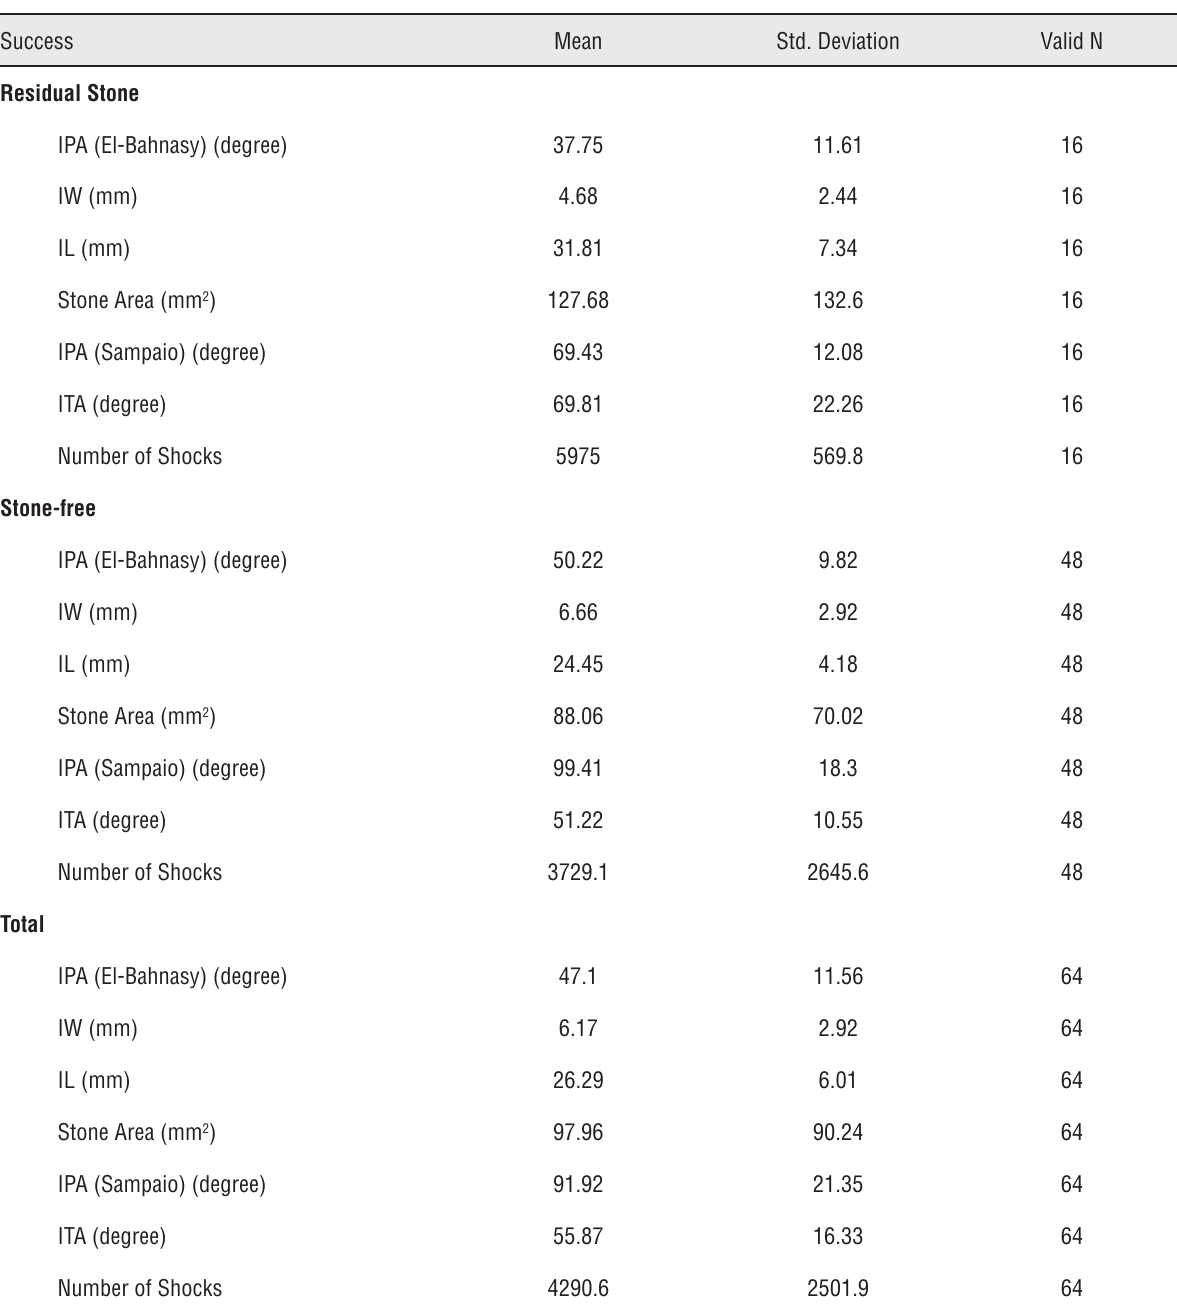
Table 1 - Mean and standard deviation values of the variables. Success Mean Std. Deviation Valid N Residual